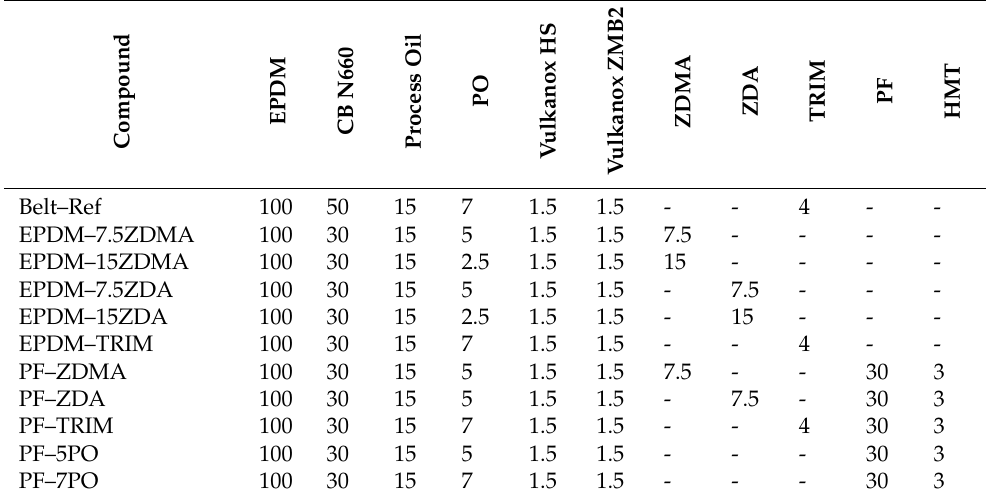
Table 2. Compositions of in situ reinforced, peroxide-cured EPDM compounds 1